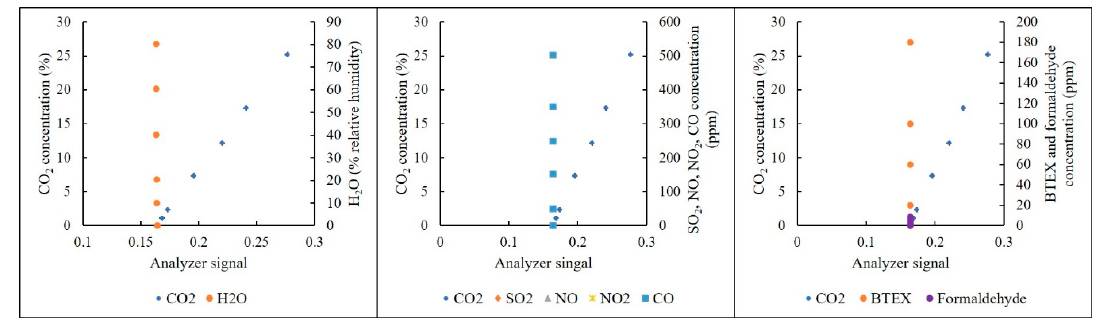
Figure 7. Effects of interference gases on the NDIR analyzer at the percentage channel.